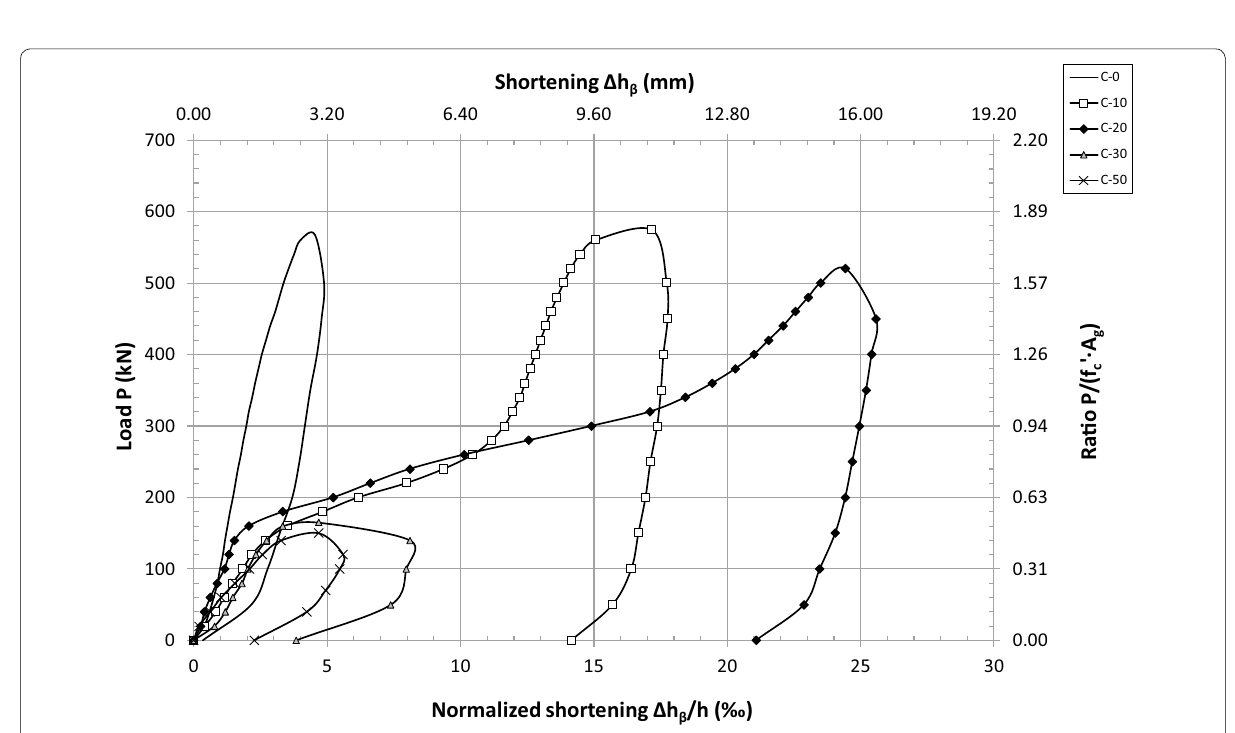
Fig. 7 Variation of compressive load relative to vertical